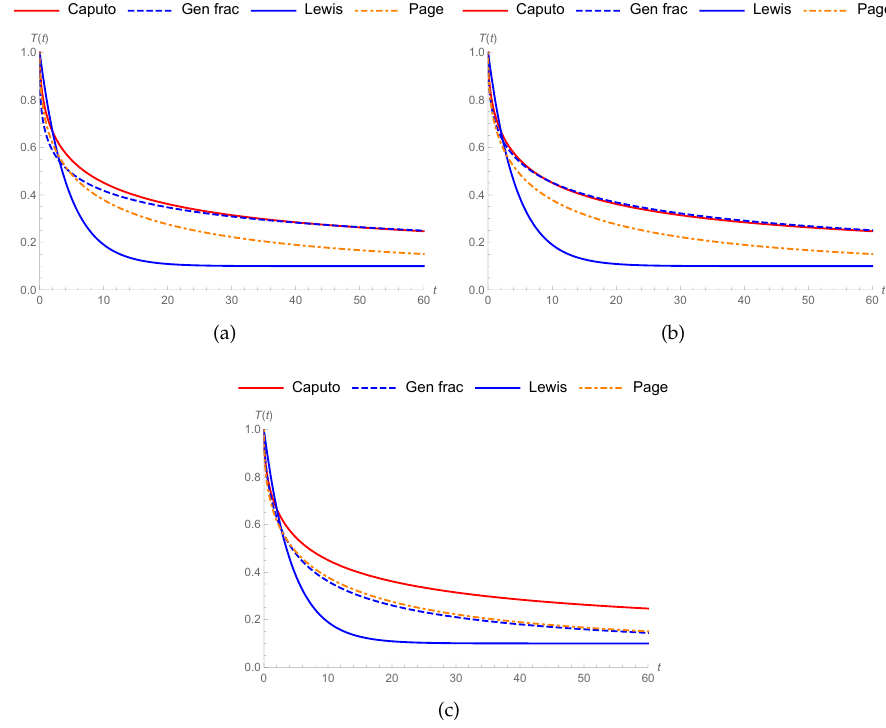
Figure 2. Comparison of drying kinetics for soybean under different models at 60 ◦ C: ( a – c ) Parameter values are shown in Table